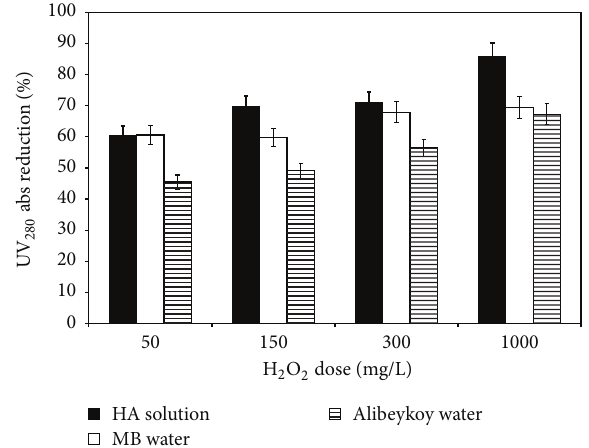
Figure 3: NOM removal performances of the hybrid process in three different water sources. < 63 𝜇 m iron oxide-coated Isp pumice, pumice dose: 3000 mg/L, HA: humic acid solution. Error bars indicate the 95% confidence